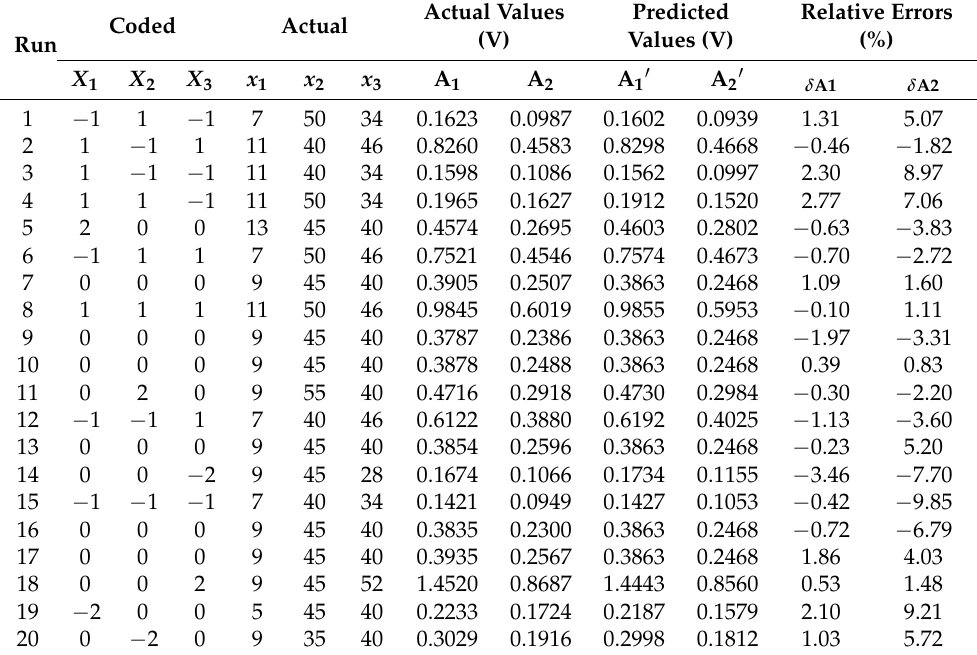
Table 2. Experimental results of